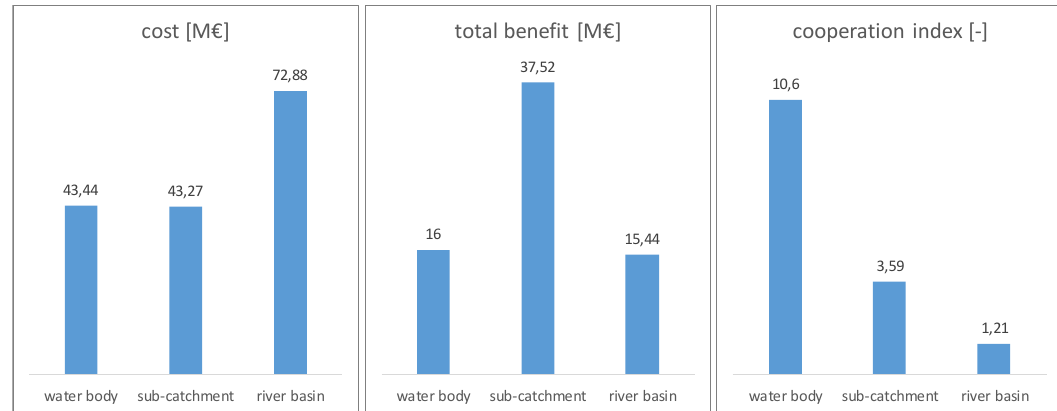
Figure 10. Changes in the cost, total benefit, and cooperation index criteria ranges alongside their corresponding spatial scales: the water body (41 spatial units), sub-catchment (10 spatial units), and river basin (1 spatial unit).